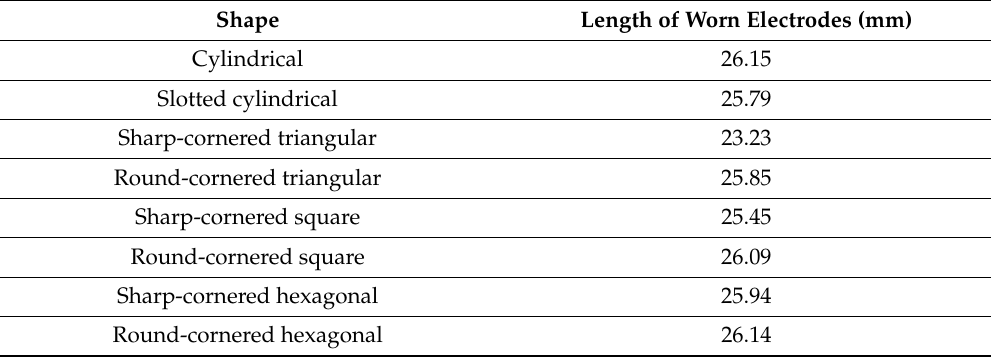
Table 5. The length of worn electrodes (the original length of all electrodes was 30 mm). Shape